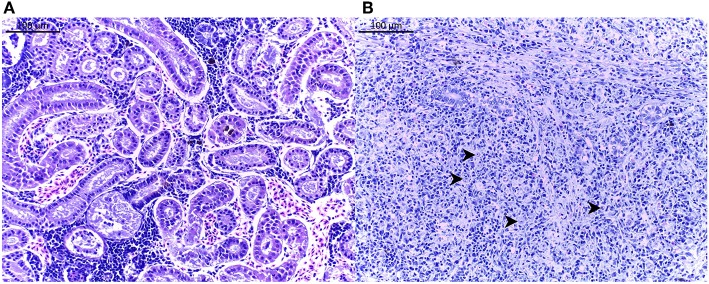
Histological pictures of brown trout Salmo trutta posterior kidney. (A) Histological assessment of an infection score of 0 (no parasite). (B) Histological assessment of an infection score of 6 (severe infection). Some parasites Tetracapsuloides bryosalmonae are shown (arrows). Scale bar = 100 μm. Pictures are taken from H&E stained slides.